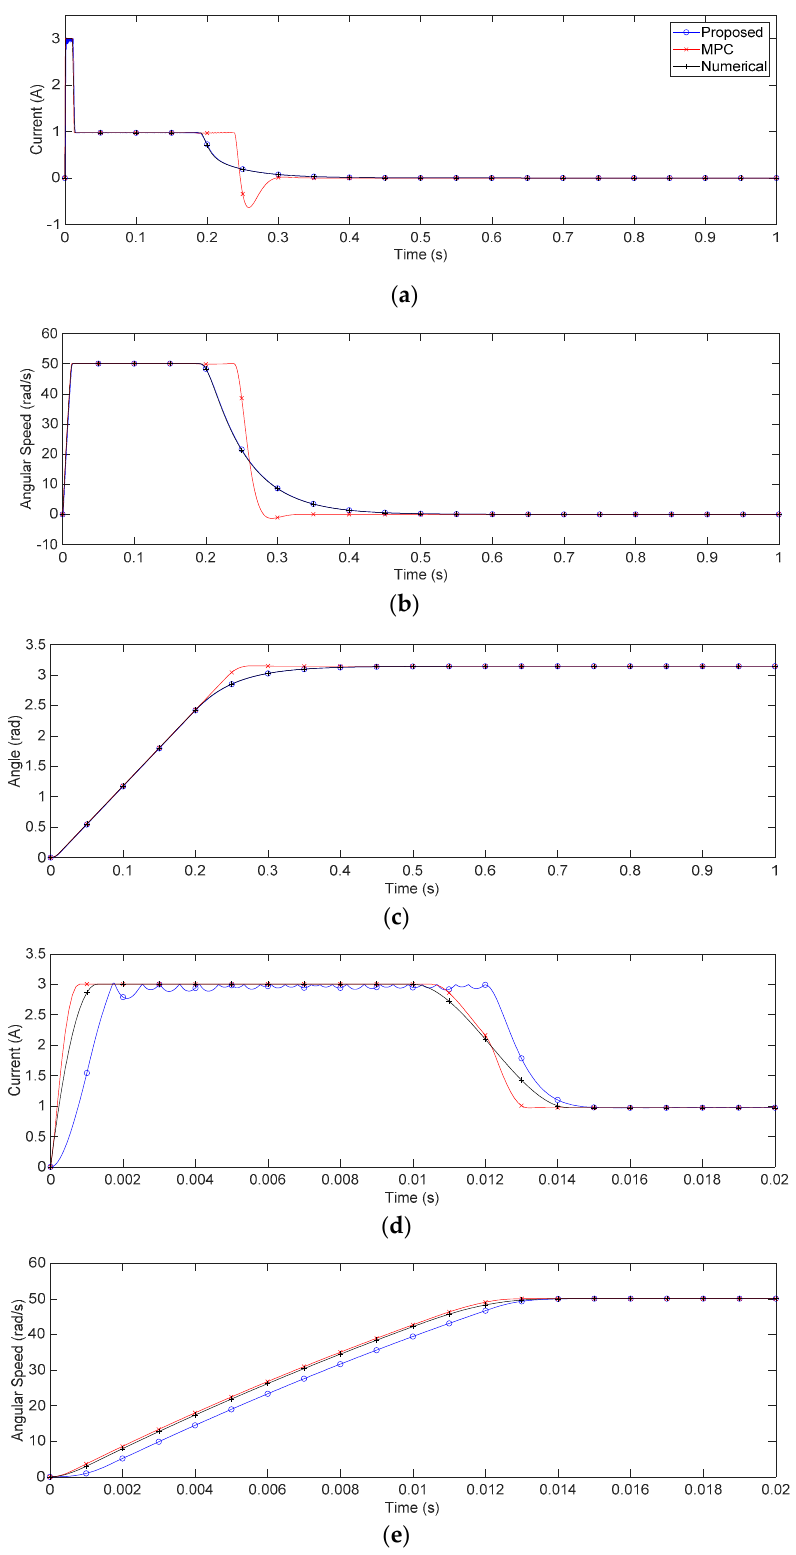
Figure 3. Simulation results of the proposed controller, the numerical method, and the implicit MPC with the first set of r and w : ( a ) motor currents from 0 to 1 s, ( b ) angular speeds of the motor rotor from 0 to 1 s, ( c ) angle of the motor rotor from 0 to 1 s, ( d ) motor currents from 0 to 0.02 s, ( e ) angular speeds of the motor rotor from 0 to 0.02 s.